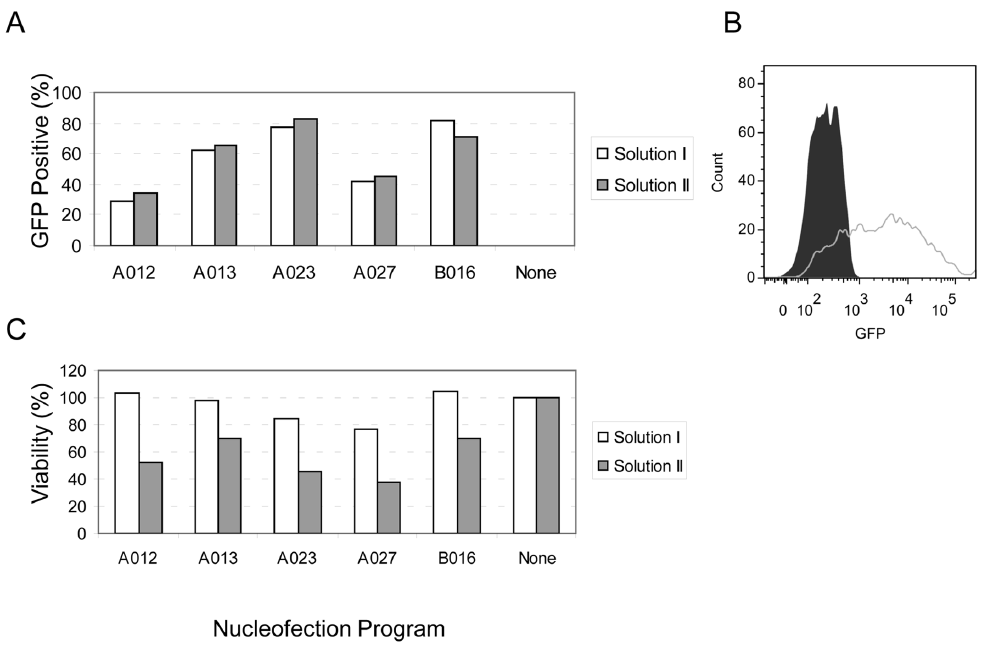
Figure 2. Optimization of nucleofection conditions. A. Percentage of GFP-positive cells. One million DF19 cells were transfected with 2 m g of the pmaxGFP plasmid using the Nucleofector 2b device and different Nucleofection solutions and programs. Two days post transfection, the percentage of GFP positive cells was determined using FACS. B. FACS profile of cells nucleofected using Solution I and program B016. The gray line represents transfected cells and the black graph untransfected cells. C. Cell viability. Cell viability was determined using Promega’s CellTiter-Glo kit. The viability of control cells that were not nucleofected but otherwise treated in the same way was taken as 100%.